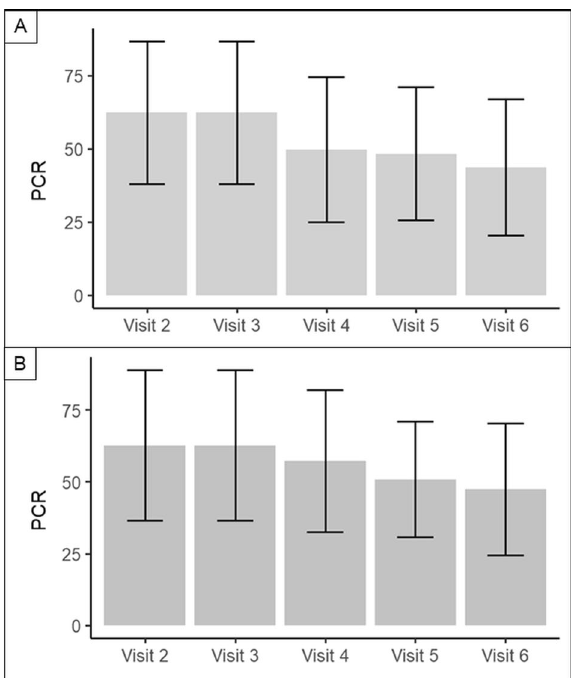
Figure 4. PCR-values from visit 2 to visit 6. A represents the HAP-group, while B shows the fluoride-group. In both groups the PCR-values decreased significantly (Friedman-test, p < 0.001). There was no difference between the HAP and the